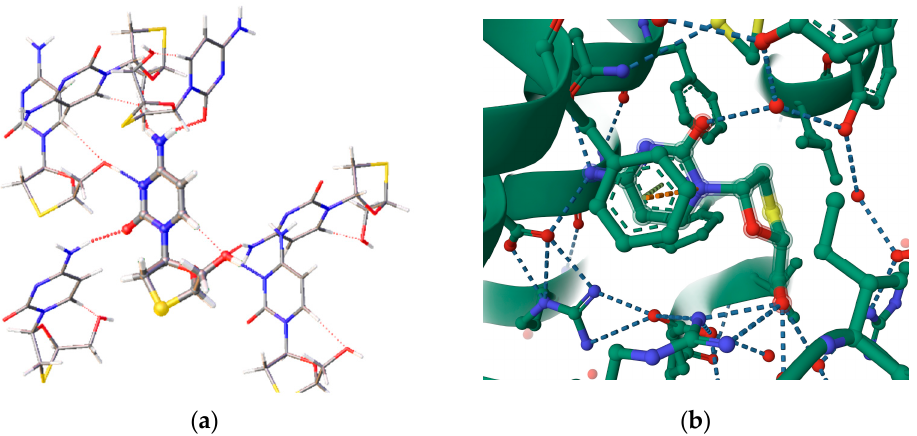
Figure 5. The H-bonding pattern of Lamivudine molecule in crystal structures of ( a ) pure 3TC (the tetragonal polymorph) and ( b ) 2NOA complex [31]. H-bonds are marked with dotted lines. It is worth mentioning that, in the 3TC–receptor complex, the values of hydrogen bonds between the 3TC and amino acid residues appear to be somewhat shorter than the corresponding ones in the crystal. For the strong N-H . . . O and O-H . . . O bonds, the values of N . . . O and O . . . O and of O . . . H and N . . . H distances are up to 0.4 Å shorter than in the crystal. In our opinion, the reason for this is related to the presence of the oxygen atoms with a high negative charge in the peptide chains. Indeed, in complex A, the hydroxyl group of 3TC participates in the strong hydrogen bond with the COO − group of the glutamine residue (the O . . . H distance is equal to 1.622 Å). In complex B there is a strong N-H . . . O bond with the COO − group of the asparagine residue (with the H . . . O distance equal to 1.694 Å). An analysis of interatomic distances in pure 3TC and complexes A and B can only give limited information related to the interactions between 3TC